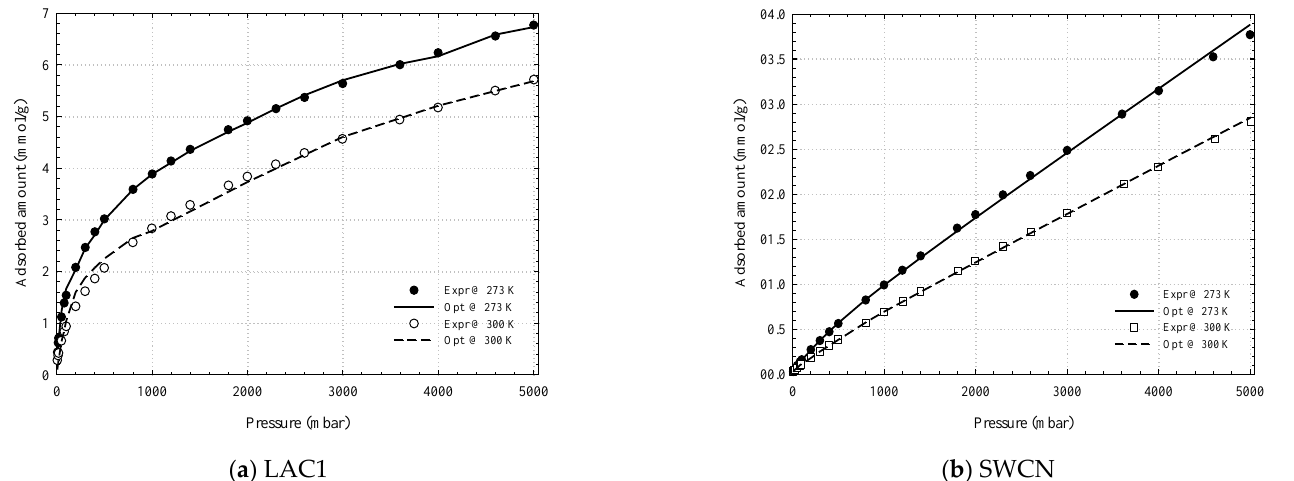
Figure 18. Comparison between the experimental data and reconstructed adsorption isotherms obtained from PSD determination for LAC1 ( a ) and SWCN ( b ) using the adsorption isotherms of CO 2 at 273 and 300 K.